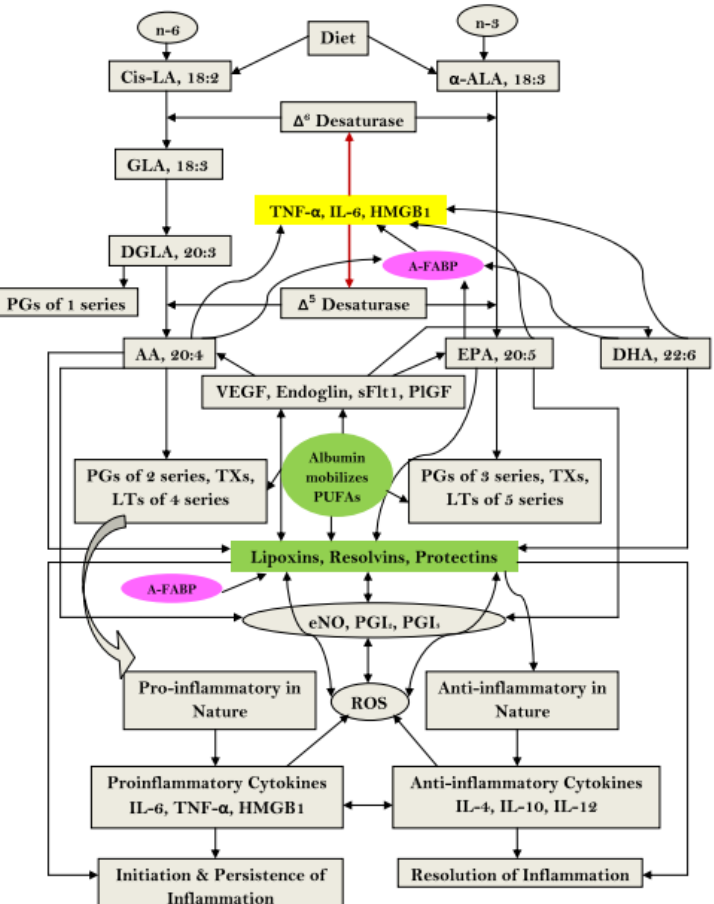
Figure 3. Schematic showing the role albumin in the metabolism of essential fatty acids and their role in inflammation. AA, arachidonic acid; A-FABP, adipose-fatty acid binding protein; ALA, alpha- linolenic acid; DGLA, dihomo-gamma-linolenic acid; DHA, docosahexaenoic acid; eNO, endothelial nitric oxide; EPA, eicosapentaenoic acid; GLA, gamma-linolenic acid; HMGB1, high-mobility group box 1; IL, interleukin; LA, linolenic acid; LT, leukotriene; PG, prostaglandin; PlGF, placental growth factor; PGI, prostacyclin; PUFA, polyunsaturated fatty acid; ROS, reactive oxygen species; sFlt1, Soluble fms-like tyrosine kinase 1; TNF α , tumor necrosis factor alpha; TX, thromboxane;